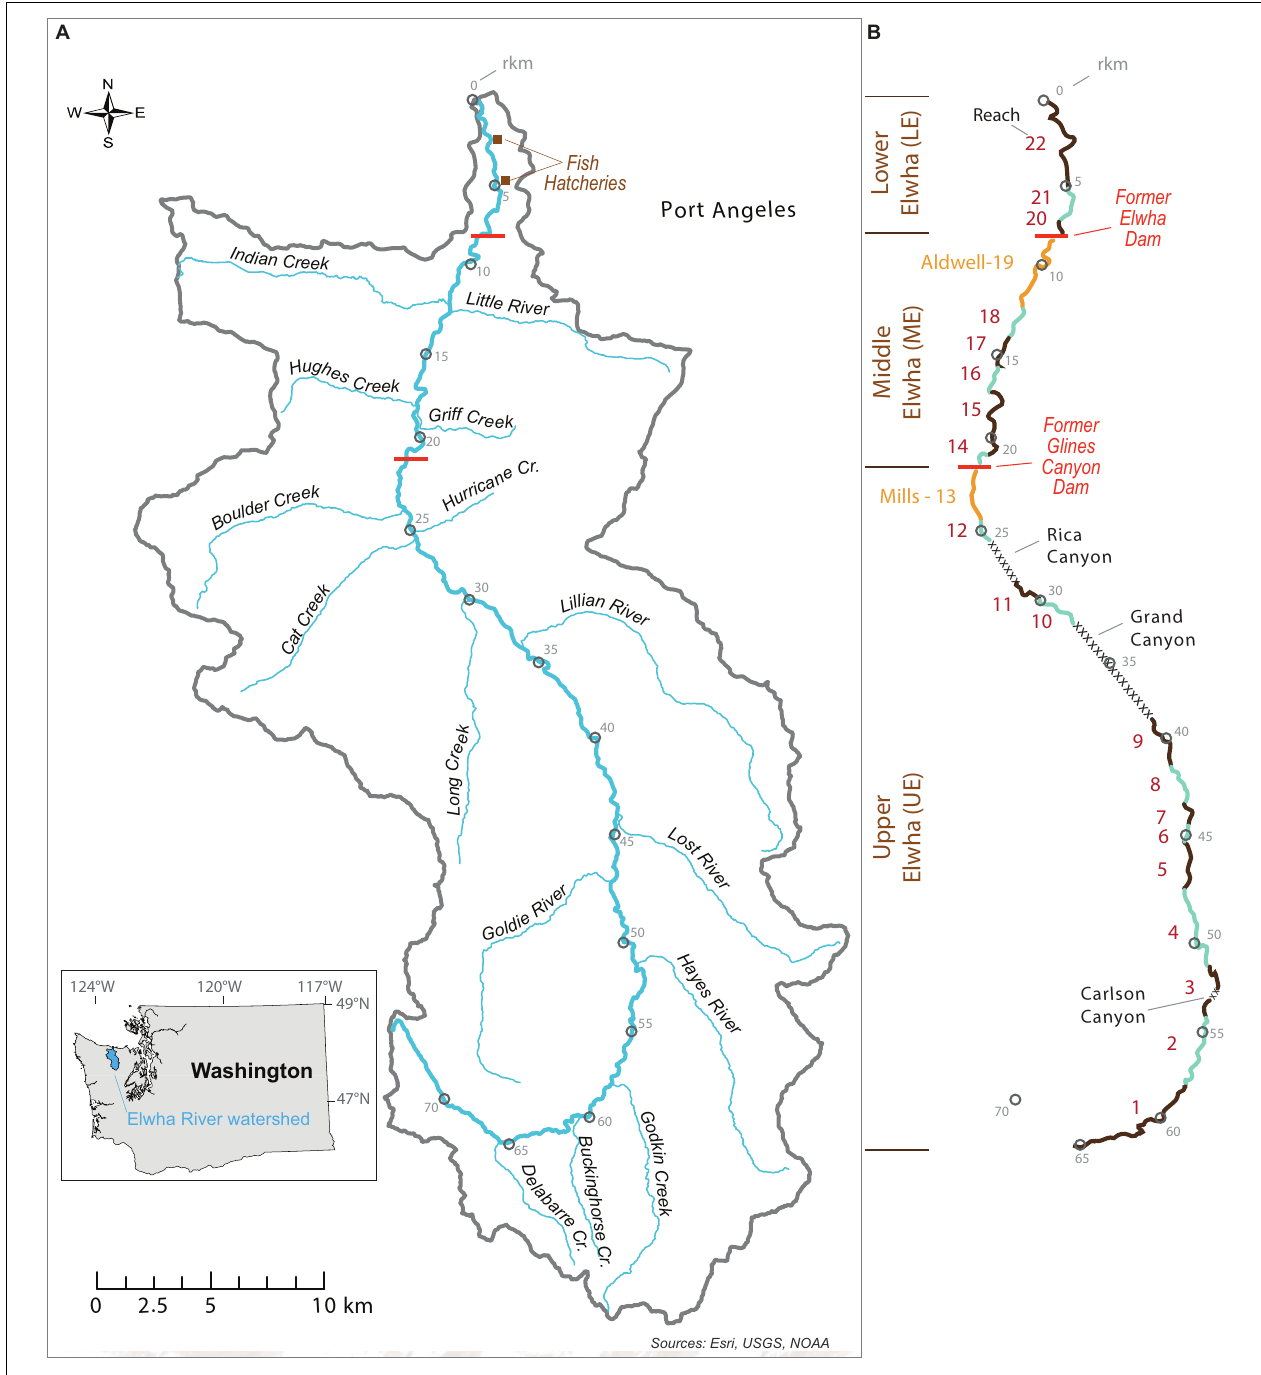
FIGURE 1 | (A) Map of the Elwha River watershed and post-dam removal hydrography showing the two former dams, two fish hatcheries, and (B) the 22 riverscape survey reaches numbered in longitudinal order and alternating color. Distances upstream from the mouth of the Elwha River are indicated with open circles and corresponding river km (rkm) measures. Canyon reaches not surveyed and the former reservoir reaches (Lake Aldwell and Lake Mills) are indicated by cross-hatch and yellow, respectively.